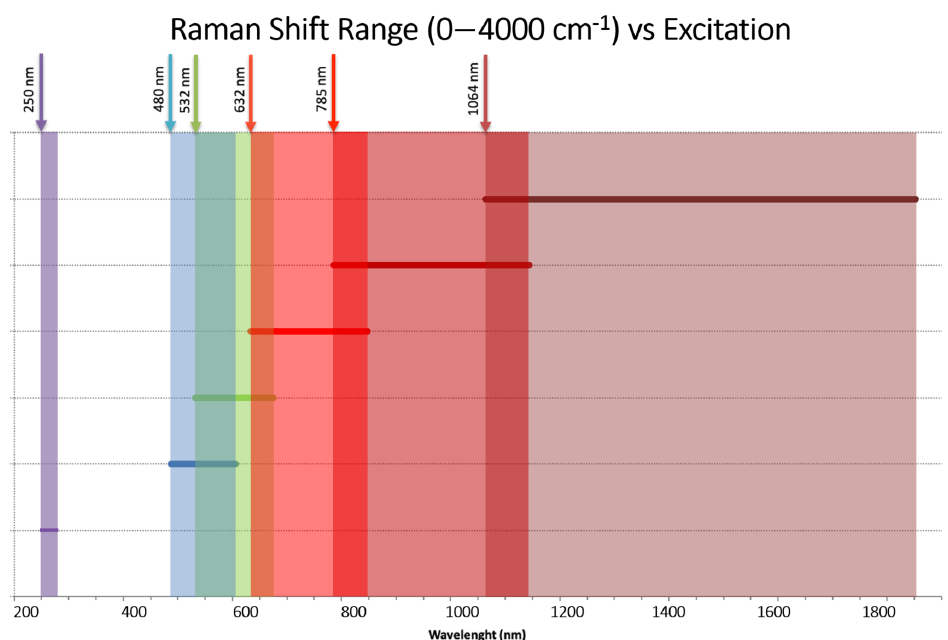
Figure 1. Raman shift range versus laser excitation. Raman shift or excitation of bounced light into the target material depends on the excitation source/laser. For a certain wavelength input, a different output shifted wavelength is obtained with different peaks. This shift can be used to identify the analysed molecules. Reprinted from